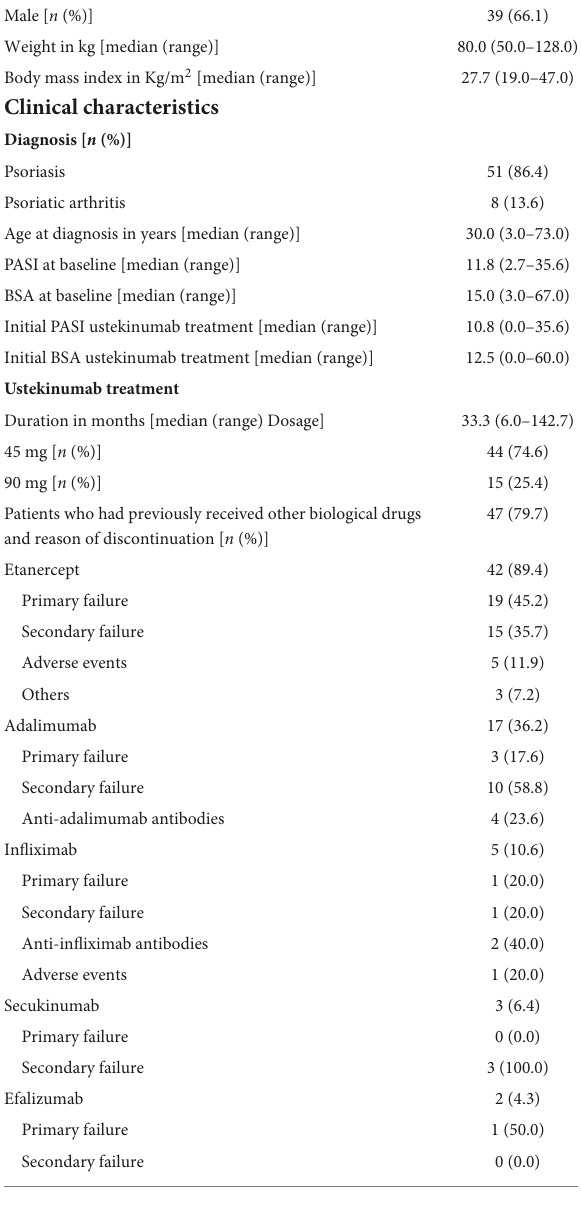
TABLE 1 Demographic and clinical characteristics of the study population. Demographic